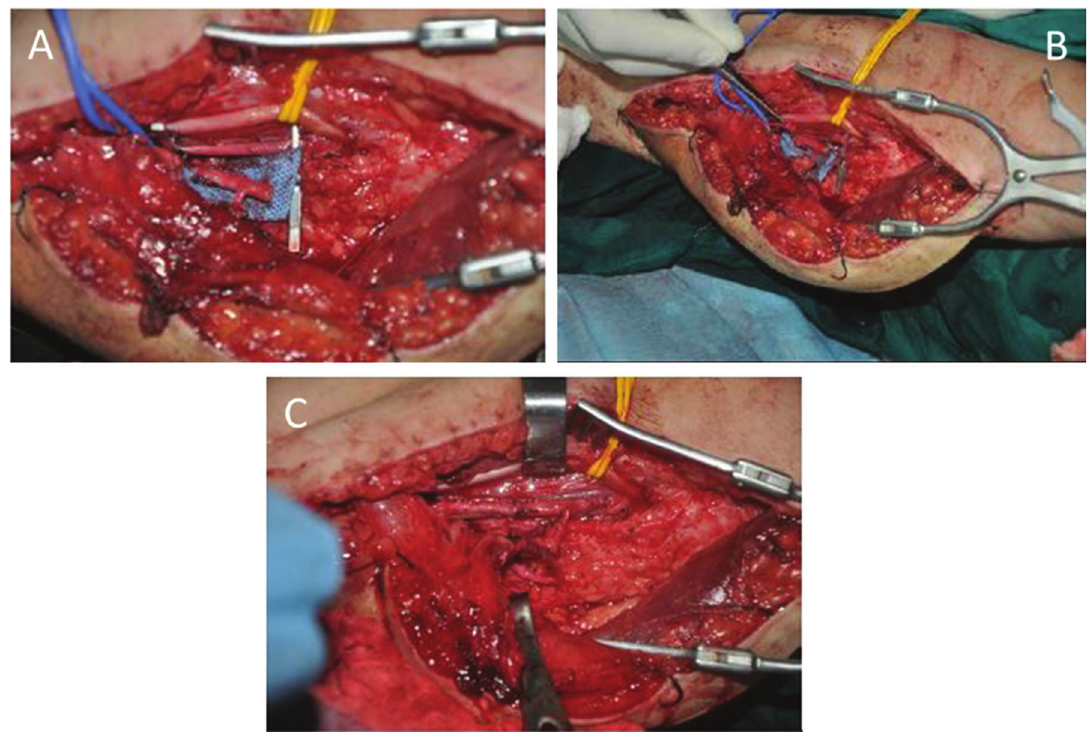
Figure 3 - Flow-through anastomosis of the T-shaped pedicle - A) The diameter of the profunda femoris segment is obviously larger than that of the nutrient artery of the gracilis. B) The brachial artery was resected, and the diameters of the segment profunda femoris and brachial artery were well matched. C) Interposed anastomosis to bridge the brachial artery. Two veins were anastomosed in direct end-to-end